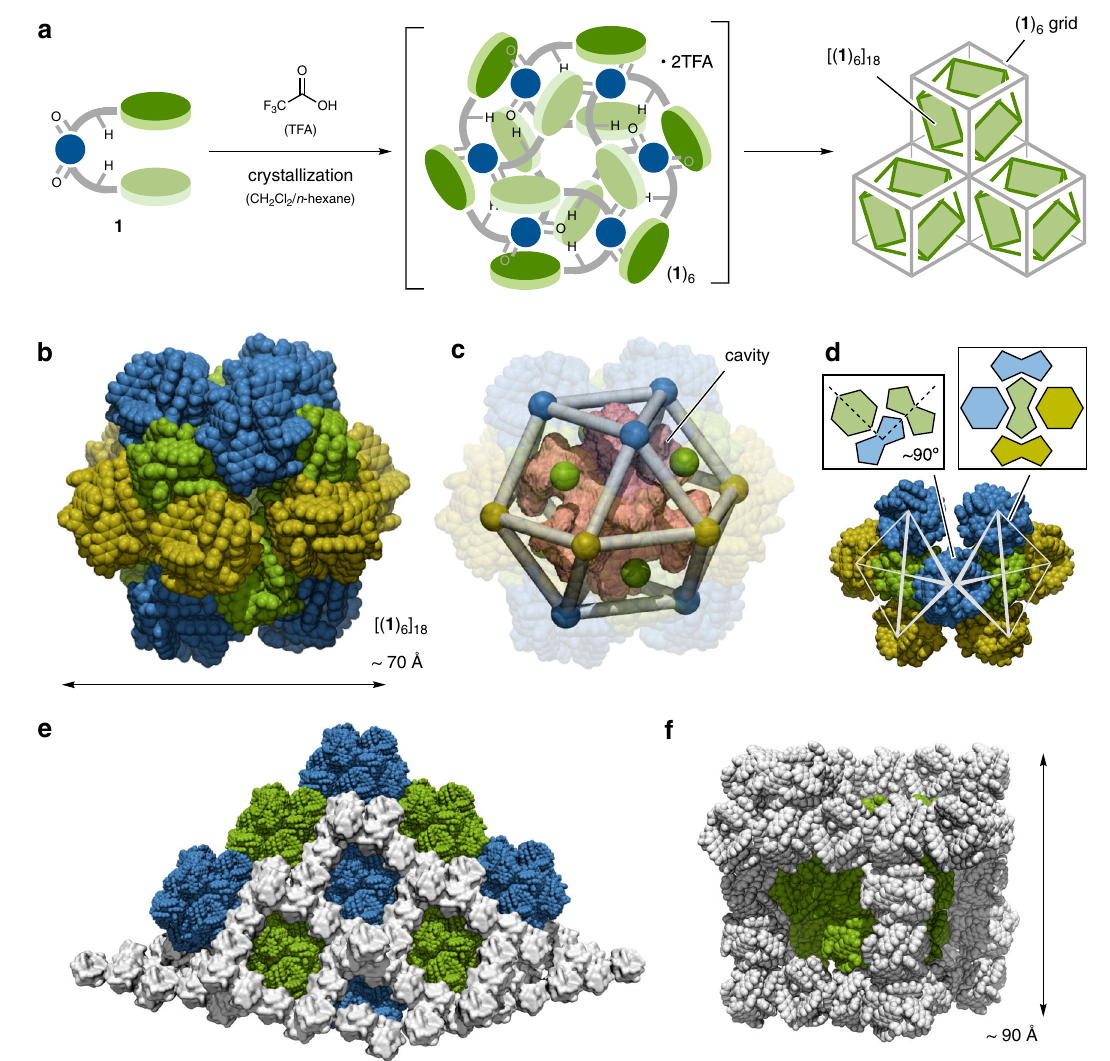
Fig. 4 | Hierarchical assembly based on (1) 6 in the solid state. a Formation of [( 1 ) 6 ] 18 and ( 1 ) 6 grids by crystallization in the presence of TFA. b , c Extracted and schematic structures of [( 1 ) 6 ] 18 with a cavity (pink color). To estimate the cavity, the relatively large holes on each surface of the cuboctahedron were obstructed by pseudoatomswitha2.6Ådiameter. d Schematicrepresentationoftheassemblyand